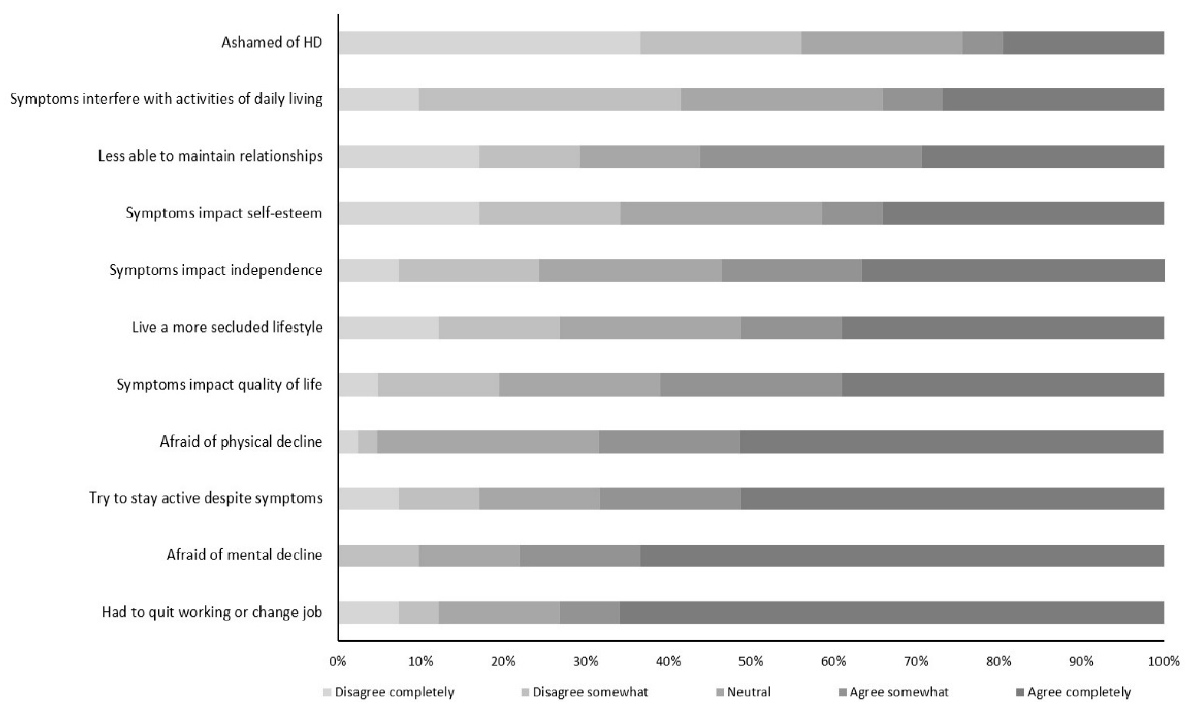
Figure 1. Impact of HD on individuals with HD. HD, Huntington’s disease. Unadjusted data.